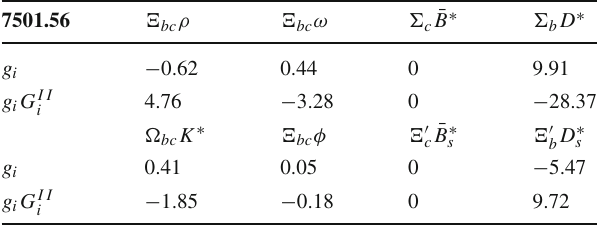
Table 19 Coupling constants to various channels and g i G II with q